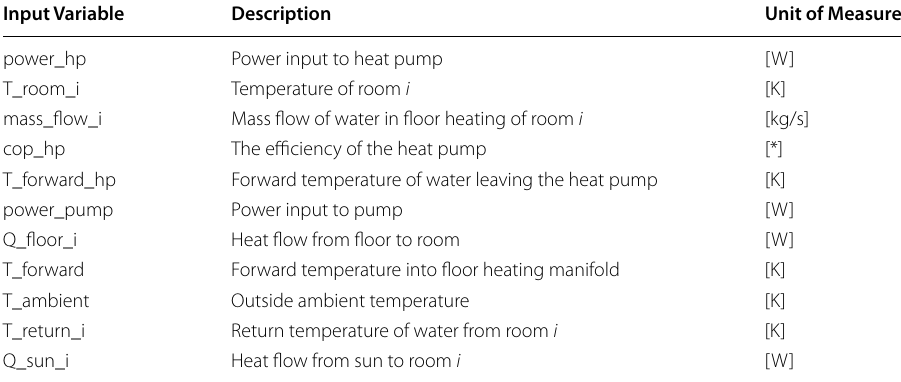
Table 3 Description of the measured variables available in the case study building Input